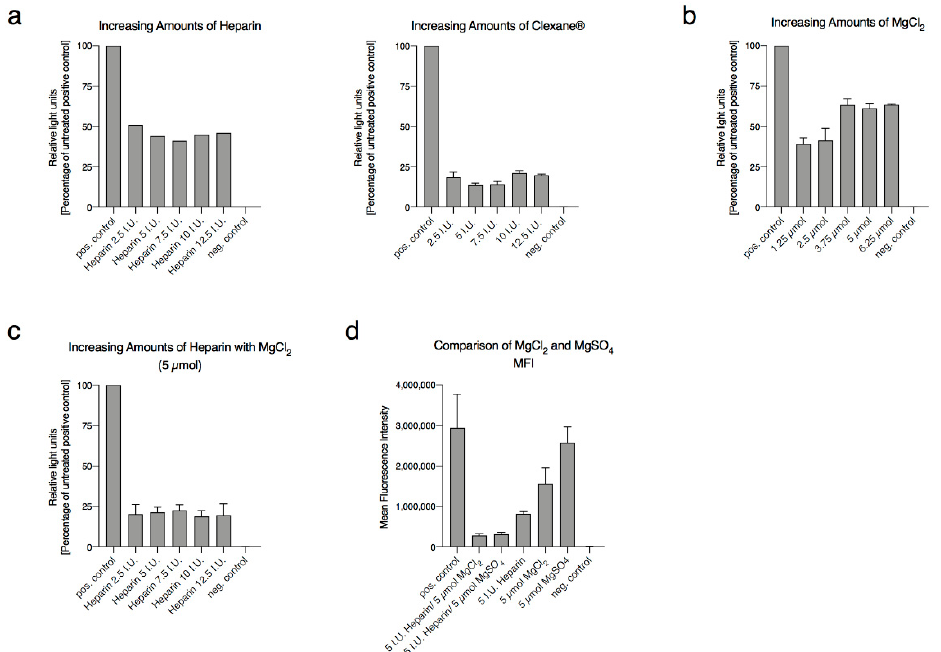
Figure 1. The effects of different concentrations of heparin, enoxaparin and MgCl 2 /MgSO 4 on human adenovirus type 5 (HAdV5). Virus and further components were mixed pre-transduction and added to CHO-K1 cells. The luciferase measurements were performed 26 h post-transduction. All experiments included a positive control referring to untreated HAdV5: ( a ) CHO-K1 cells were infected with 1000 viral particles per cell with HAdV5 in the presence of different international units (I.U.) of heparin and enoxaparin; ( b ) Transduction rates of HAdV5 in the presence of increasing amounts of MgCl 2 ; ( c ) Infectivity of HAdV5 at 1000 viral particles per cell in the presence of different amounts of heparin and 5 µ mol of MgCl 2 ; ( d ) Effects of MgCl 2 and MgSO 4 on HAdV5 transduction rates. Experiments were performed in triplicates and repeated three times. The mean standard errors are shown.